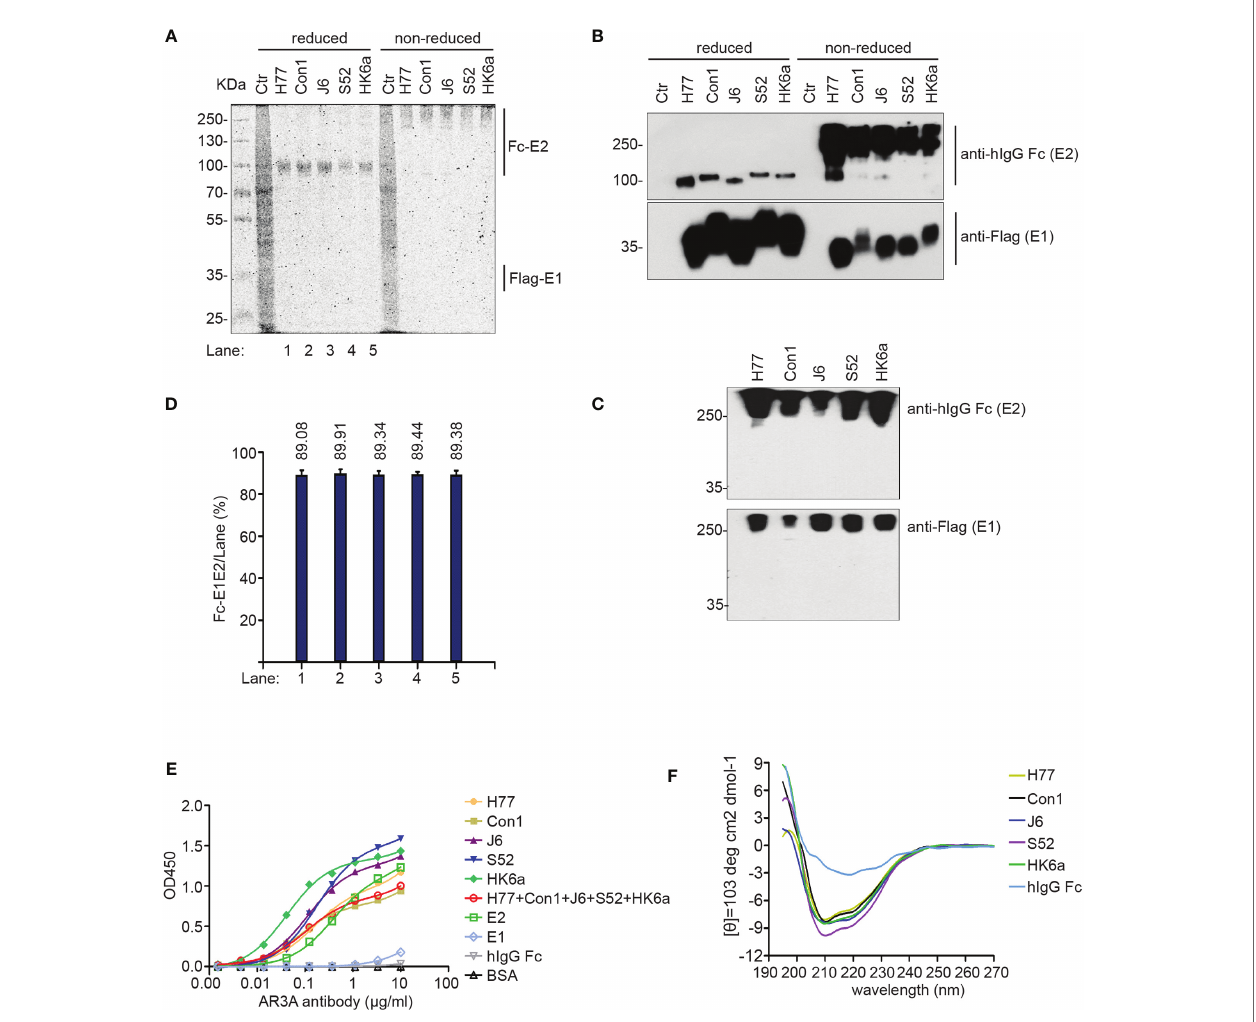
FIGURE 2 | Characterization of the puri fi ed Fc-E1E2. (A, B) Coomassie brilliant blue staining analysis (A) and Western blotting analysis (B) of puri fi ed Fc-E1E2 from fi ve sub-genotypes (H77, Con1, J6, S52, HK6a) under reducing and non-reducing conditions. (C) Native Western blotting of puri fi ed Fc-E1E2 from H77, Con1, J6, S52 and HK6a. (D) Data in (D) represent Fc-E1E2 purity from densitometry analysis to (A) . (E) AR3A antibody assay in ELISA. Precoated proteins (0.1 m g) of Fc- E1E2, BSA, E2, hIgG Fc, E1 was incubated with serially diluted AR3A antibody. Mean ± SEM of three wells were shown. (F) CD spectra of Fc-E1E2 from H77, Con1, J6, S52, HK6a and hIgG Fc as control in 10 m M sodium phosphate. Data are shown as a representative result from at least three independent against multiple epitopes of E1E2 protein were induced in all serum immunized groups.